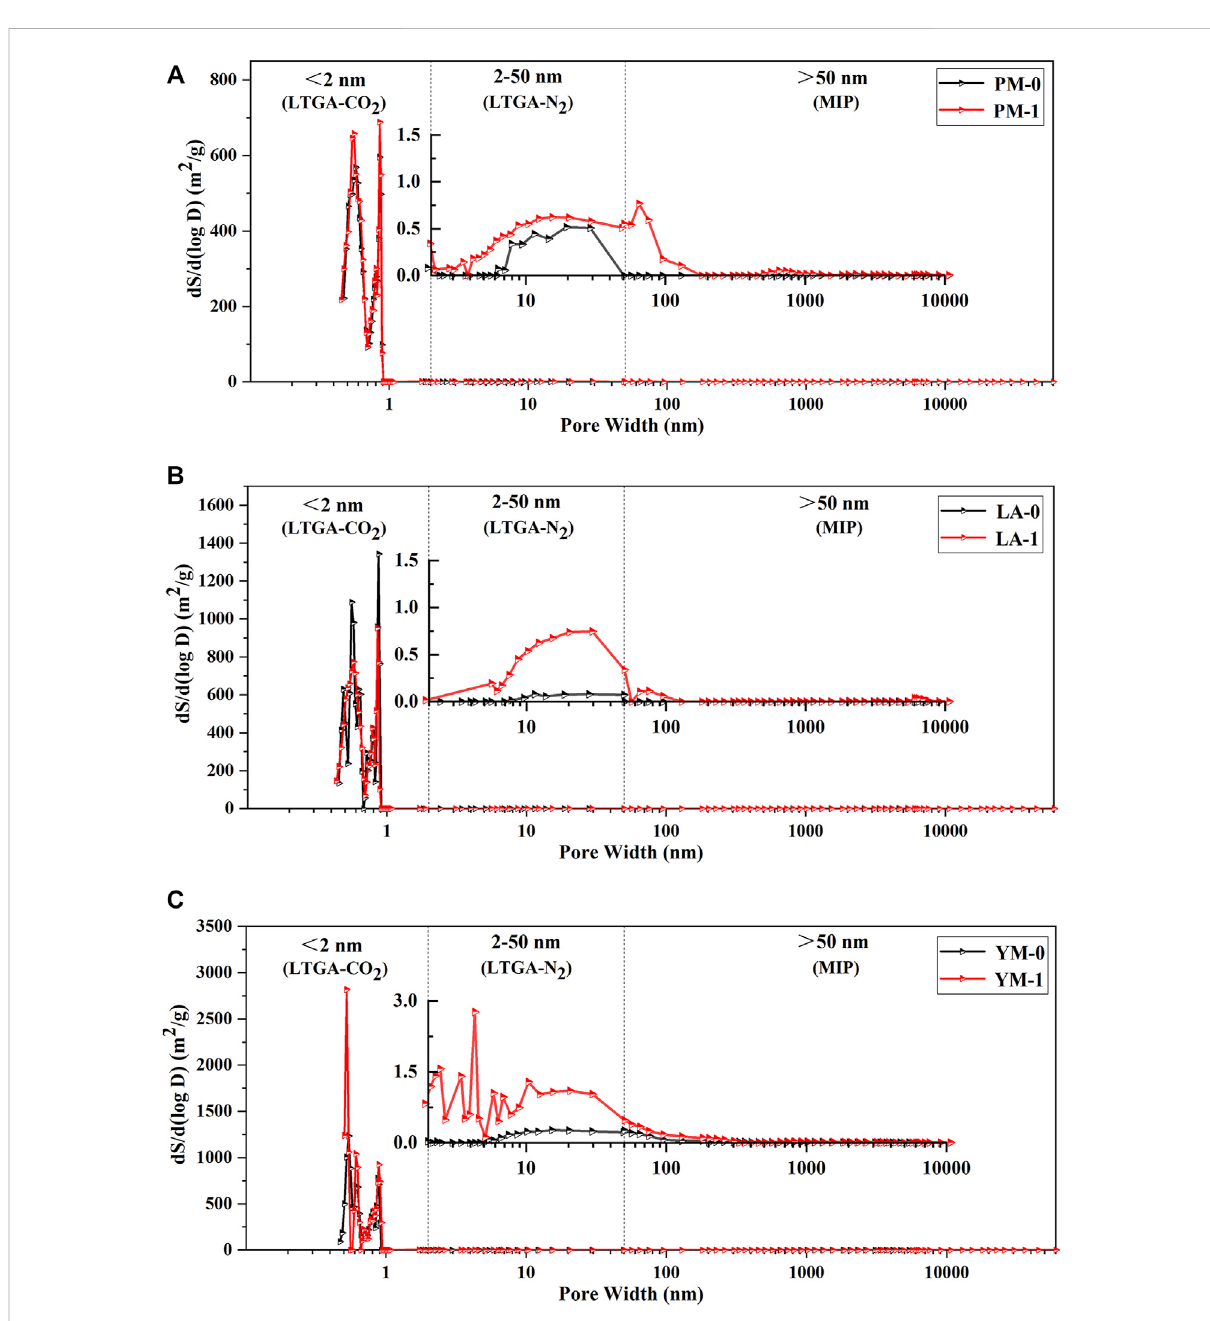
FIGURE 8 Full-sizedporeareadistributioncurvesoftherawandacidi fi edcoalsamples,andtheinsertswerethepartialenlargementcurves: (A) PM; (B) LA; (C)